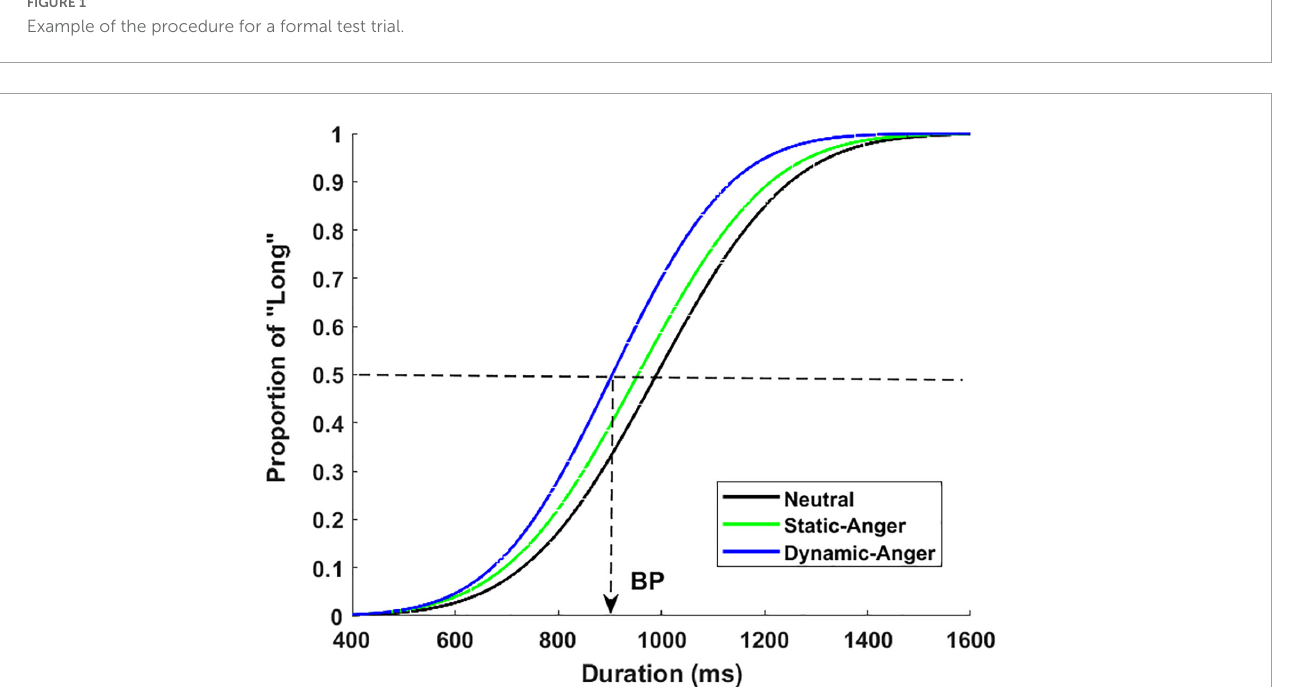
FIGURE2 Proportion of long responses plotted against the different durations for dynamic angry, static angry, and neutral faces.